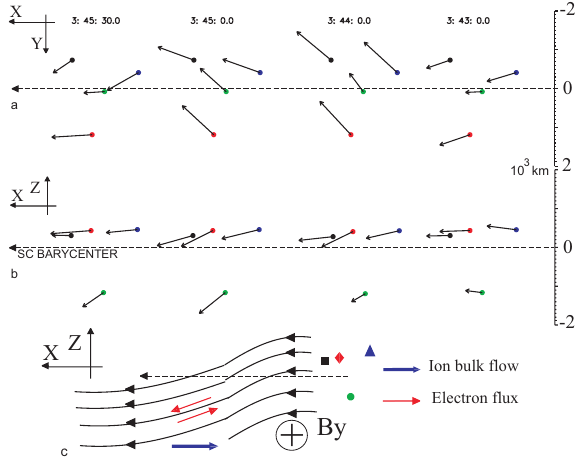
Fig. 8. Interval A 2: Projections of the magnetic field at the four s/c (black arrows) on XY (a) and on XZ (b) GSM planes at four successive instances. Panel (c) presents the interpretation cartoon.